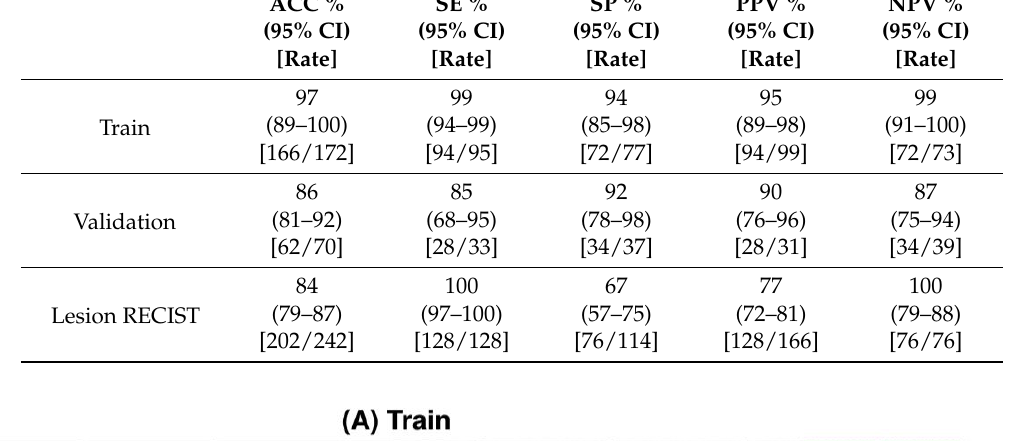
Table 1. Decision tree performances on training and validation set.